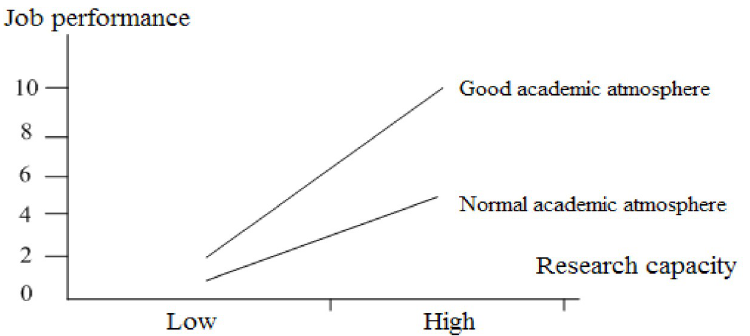
Figure 2. Coordination of academic atmosphere between research capacity and job